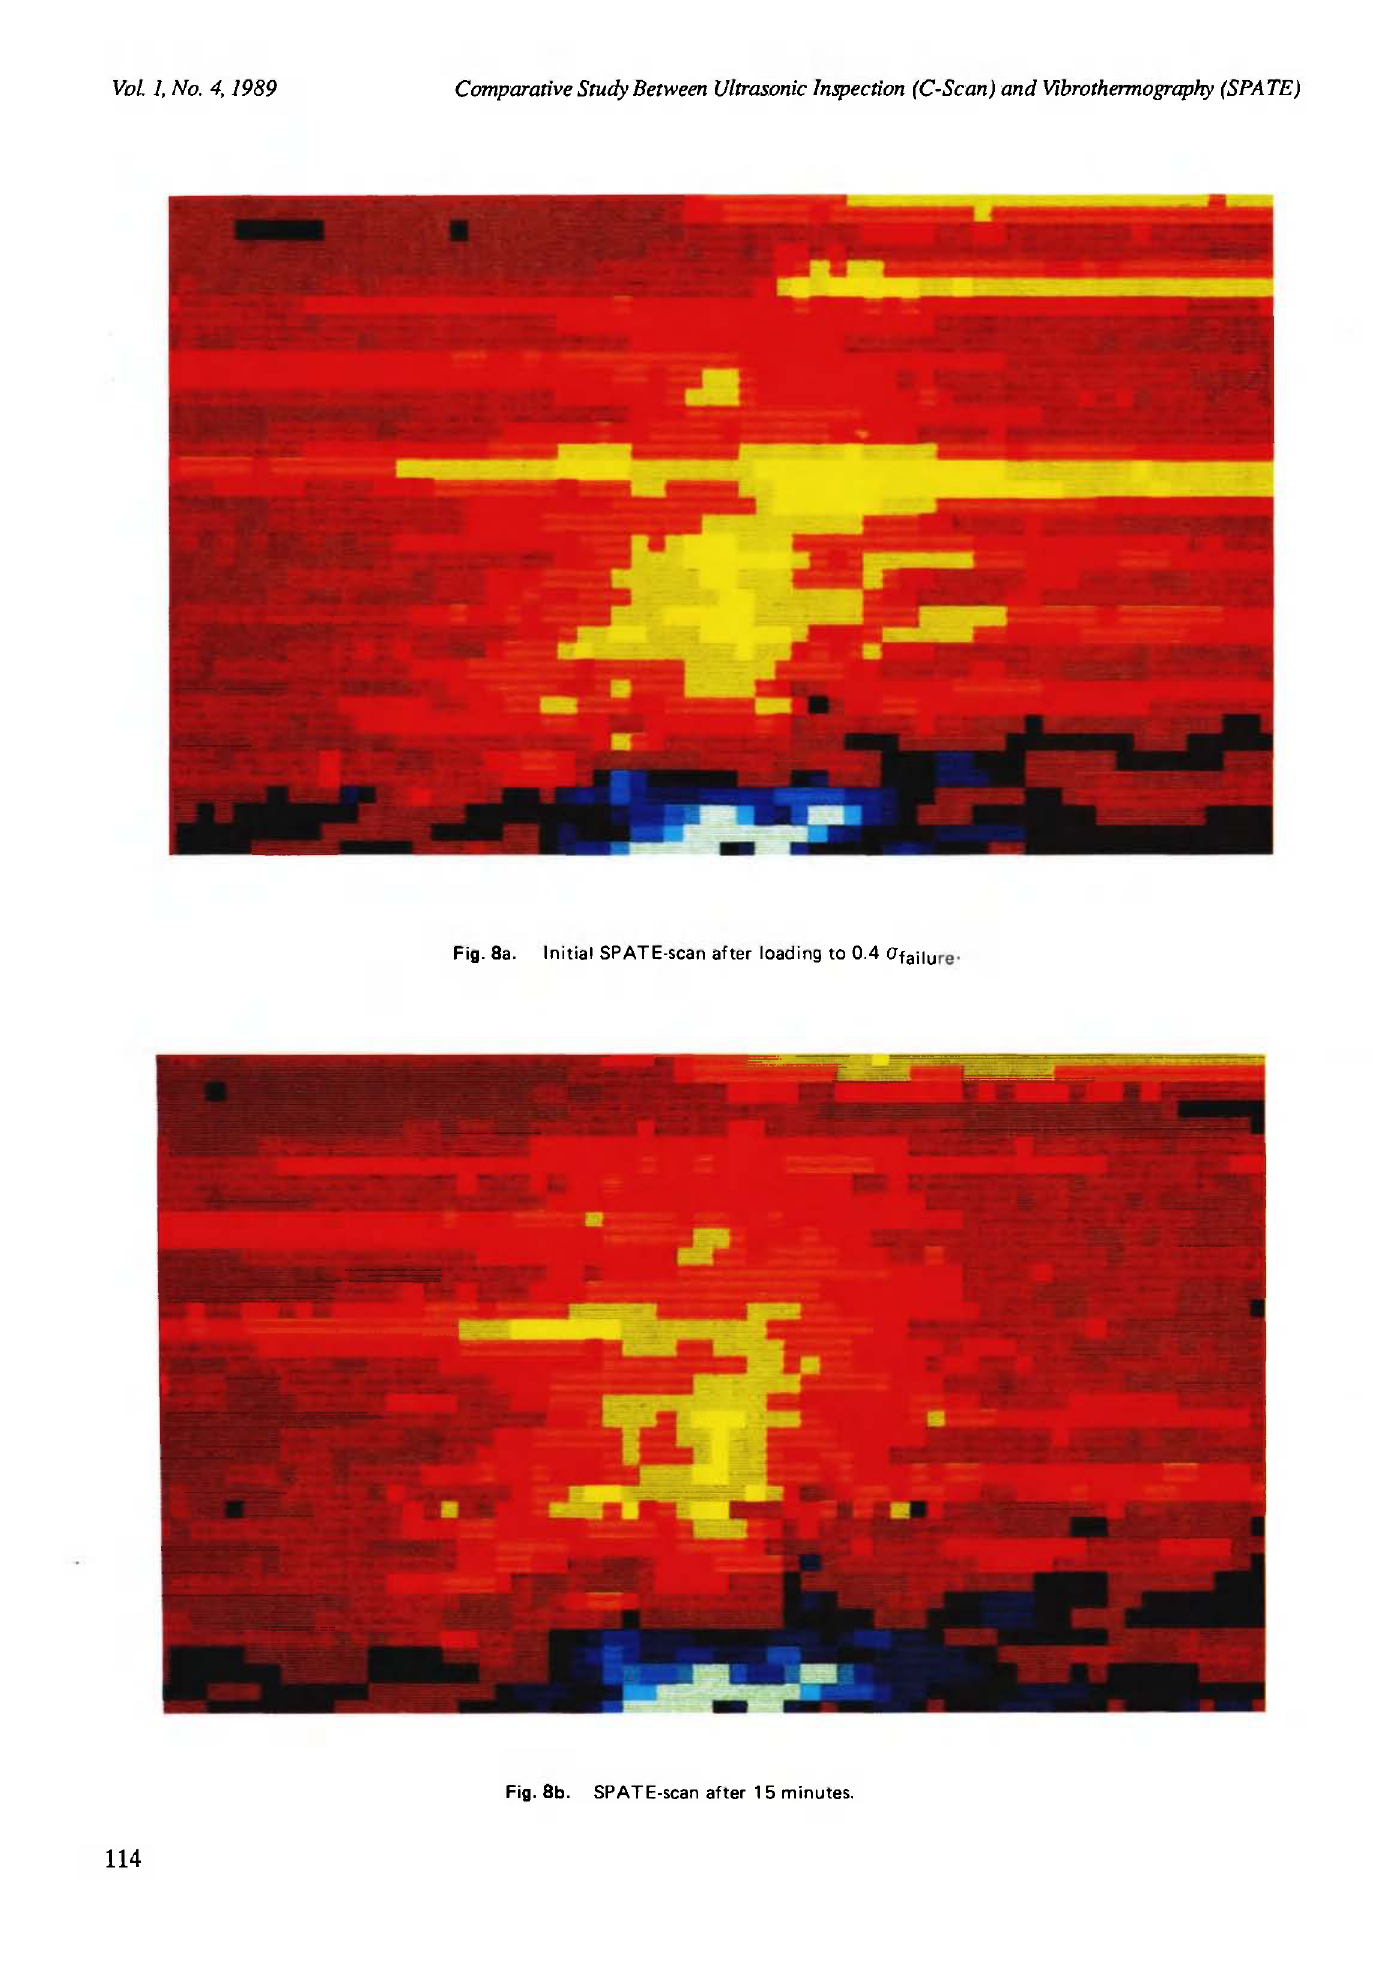
Fig. 8b. SPATE-scan after 1 5